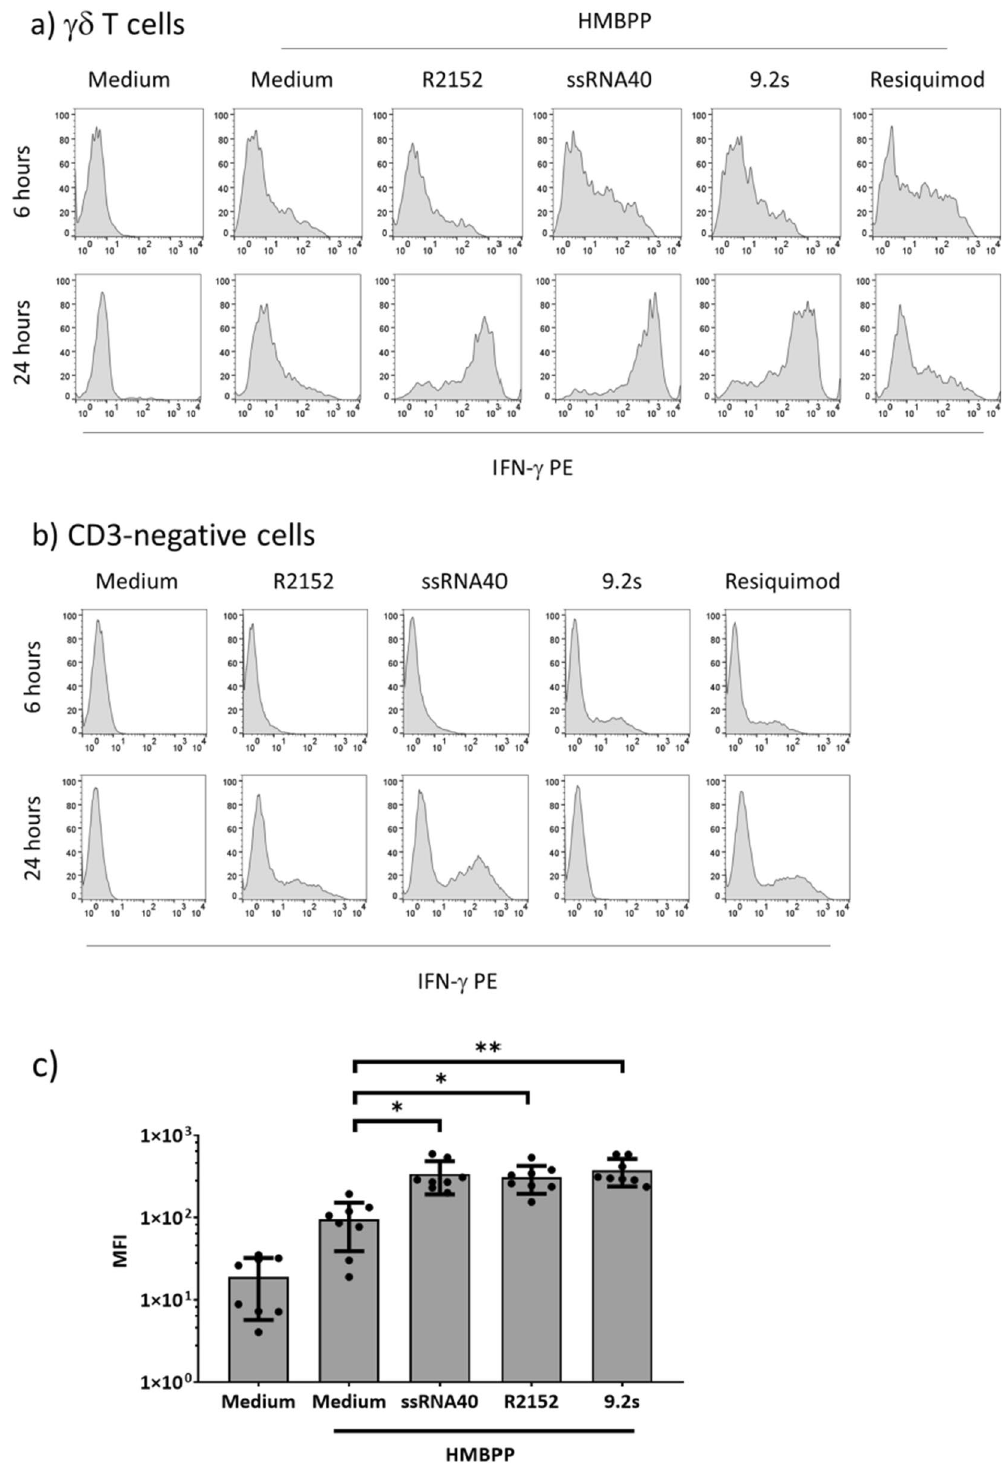
Figure 2. Kinetics of IFN-γ induction in γδ T cells and CD3-negative lymphocytes. PBMC were cultured in the presence or absence of 1 nM HMBPP and the indicated TLR ligands. After 6 and 24 h, the intracellular expression of IFN-γ was analyzed with a gate set on ( a ) CD3 + Vδ2 + γδ T cells, or ( b ) CD3-negative lymphocytes (i.e., mainly NK cells). Representative histograms are shown in ( a ) and ( b ). A summary of eight experiments is presented in ( c ). Results are expressed as mean fluorescence intensity (MFI) ± SD. Statistical significance is indicated with * p < 0.05, ** p <